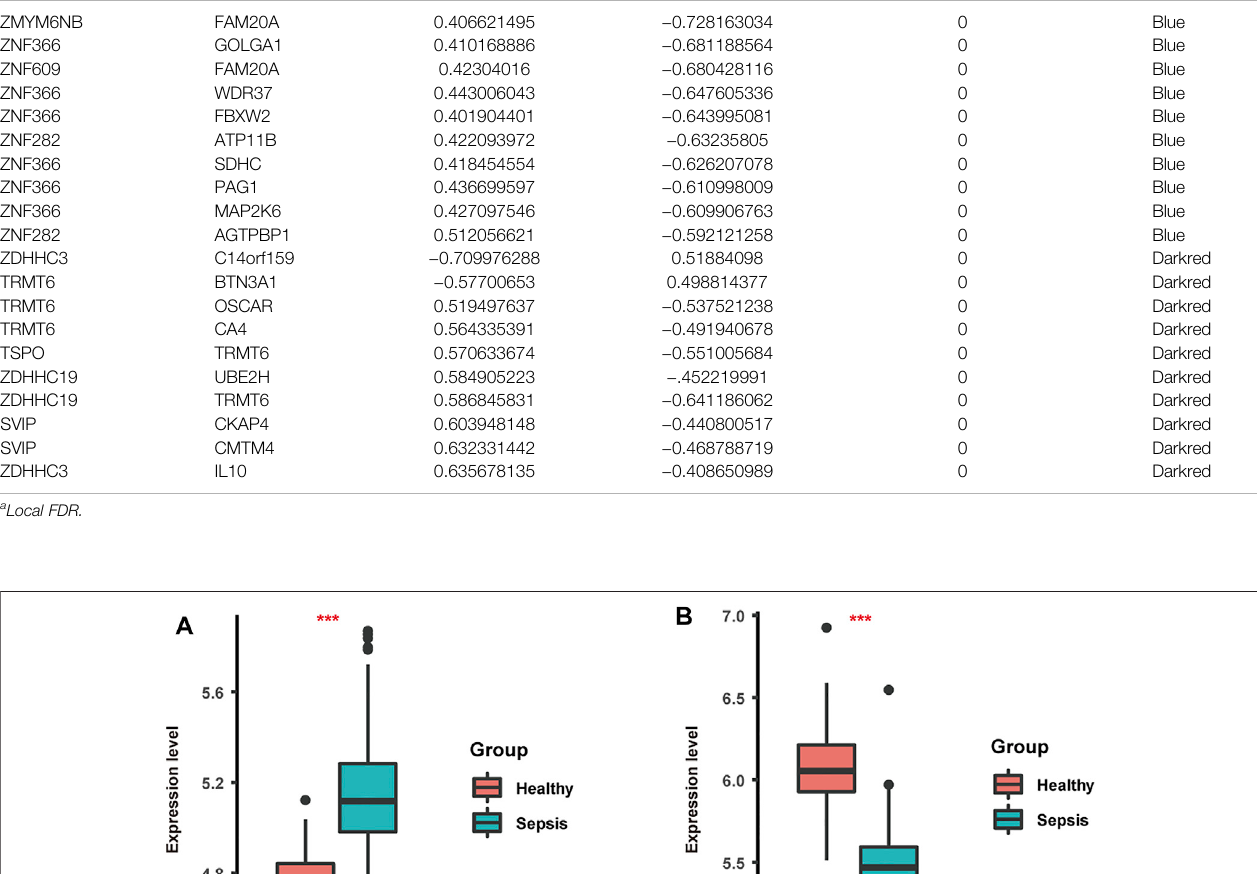
TABLE 1 | Top ten signi fi cant differentially correlated gene pairs from blue and darkred modules between healthy and sepsis tissues. Molecule X